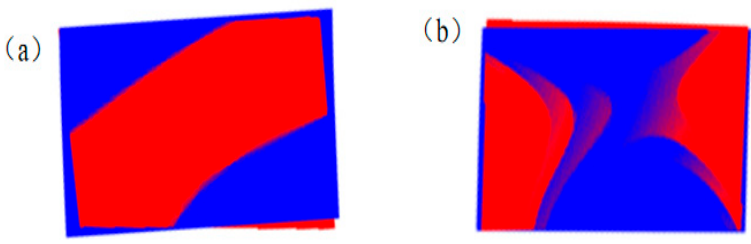
Figure 8. Point cloud registration effect comparison: ( a ) S-ICP algorithm, ( b ) region-registration algorithm.